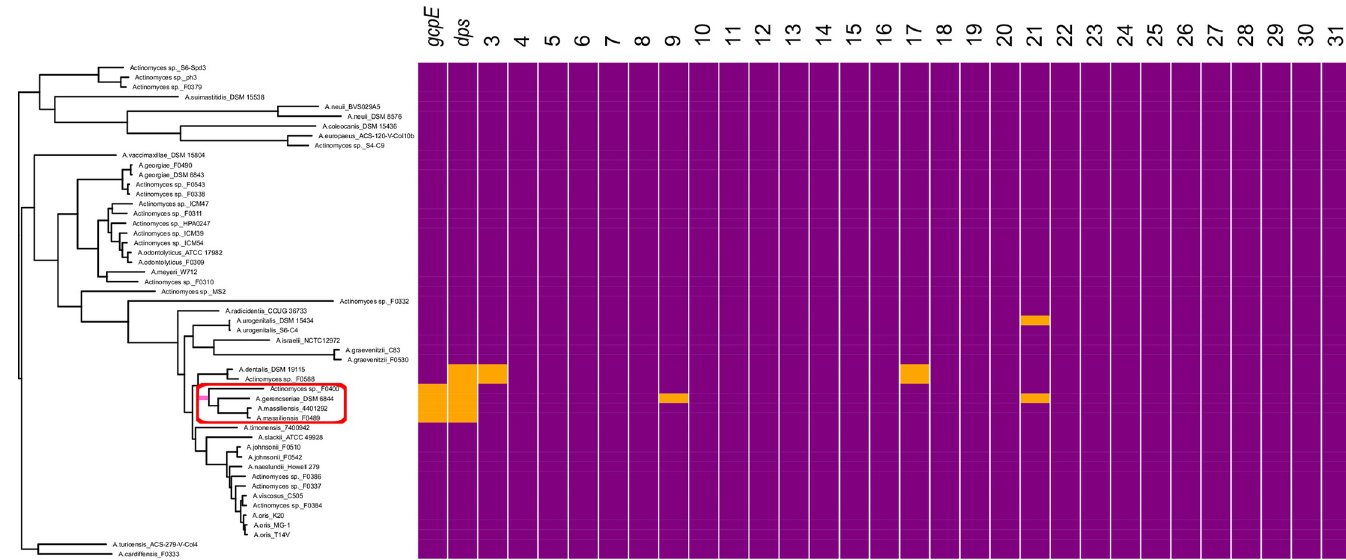
Fig 3. Phylogenetic distribution of the MRONJ-associated genes in the core genome phylogeny of Actinomyces . Strains in the tree are listed in S2 Table . Each column indicates a MRONJ-associated gene ordered in terms of the abundance of the gene across the 10 MRONJ samples (Fig 2B). Gene names are indicated for the top 2 genes. In the heatmap at the right, orange and purple indicate presence and absence of the genes, respectively. The red circle indicates a notable sub-clade mentioned in the main text. Pink indicates a branch separating the sub-clade from the others with 100% bootstrap support.